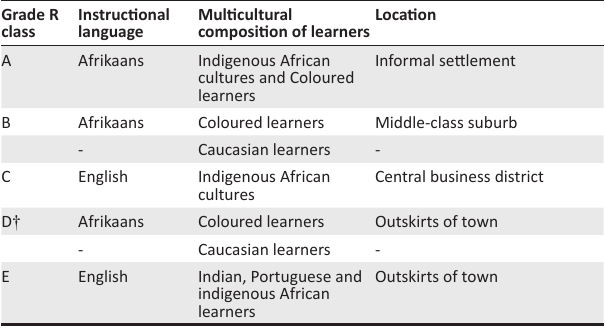
TABLE 1: Description of cases in the multiple case